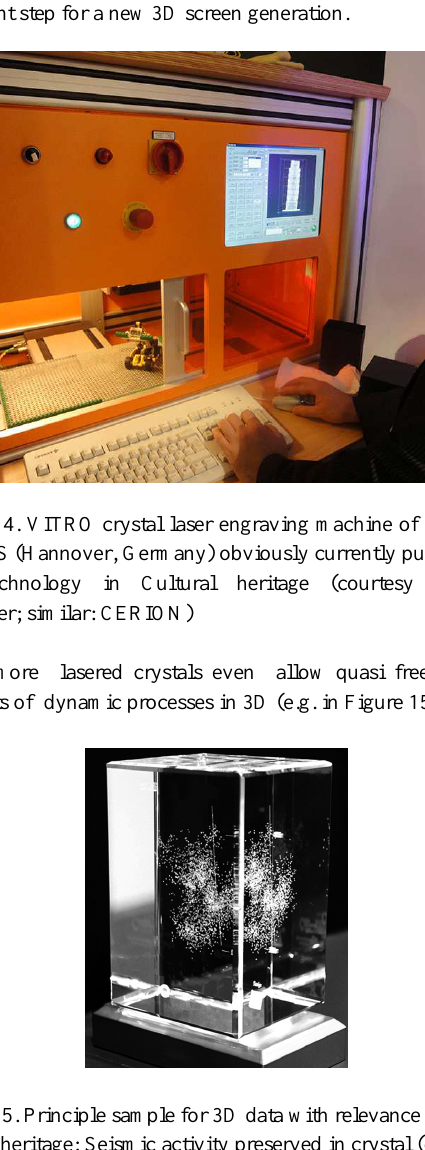
Figure 15. Principle sample for 3D data with relevance for cultural heritage: Seismic activity preserved in crystal (courtesy R.Titze/LOOXIS (Hannover, Germany), sample modified by W.